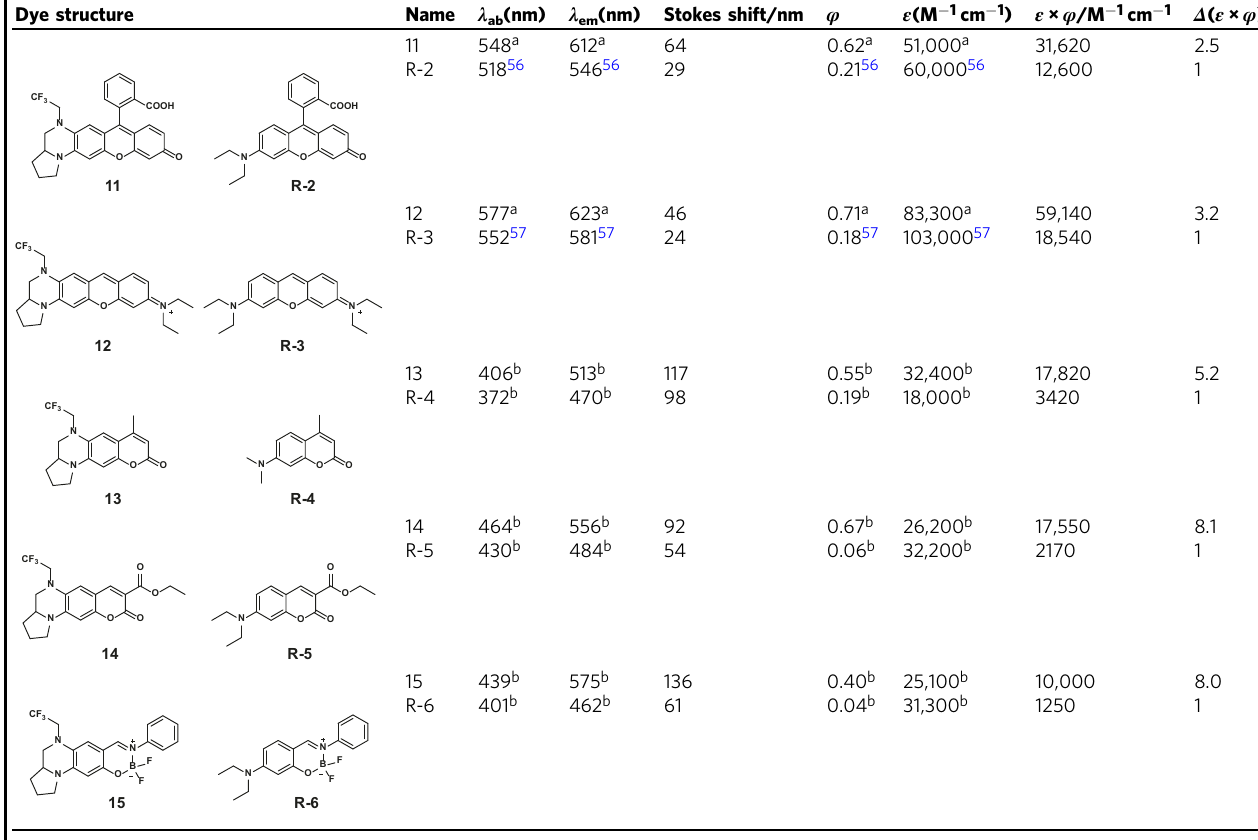
Table 1 Spectroscopic data of 11 – 15 and reference fl uorophores R-(2 – 6) 56,57 . Dye